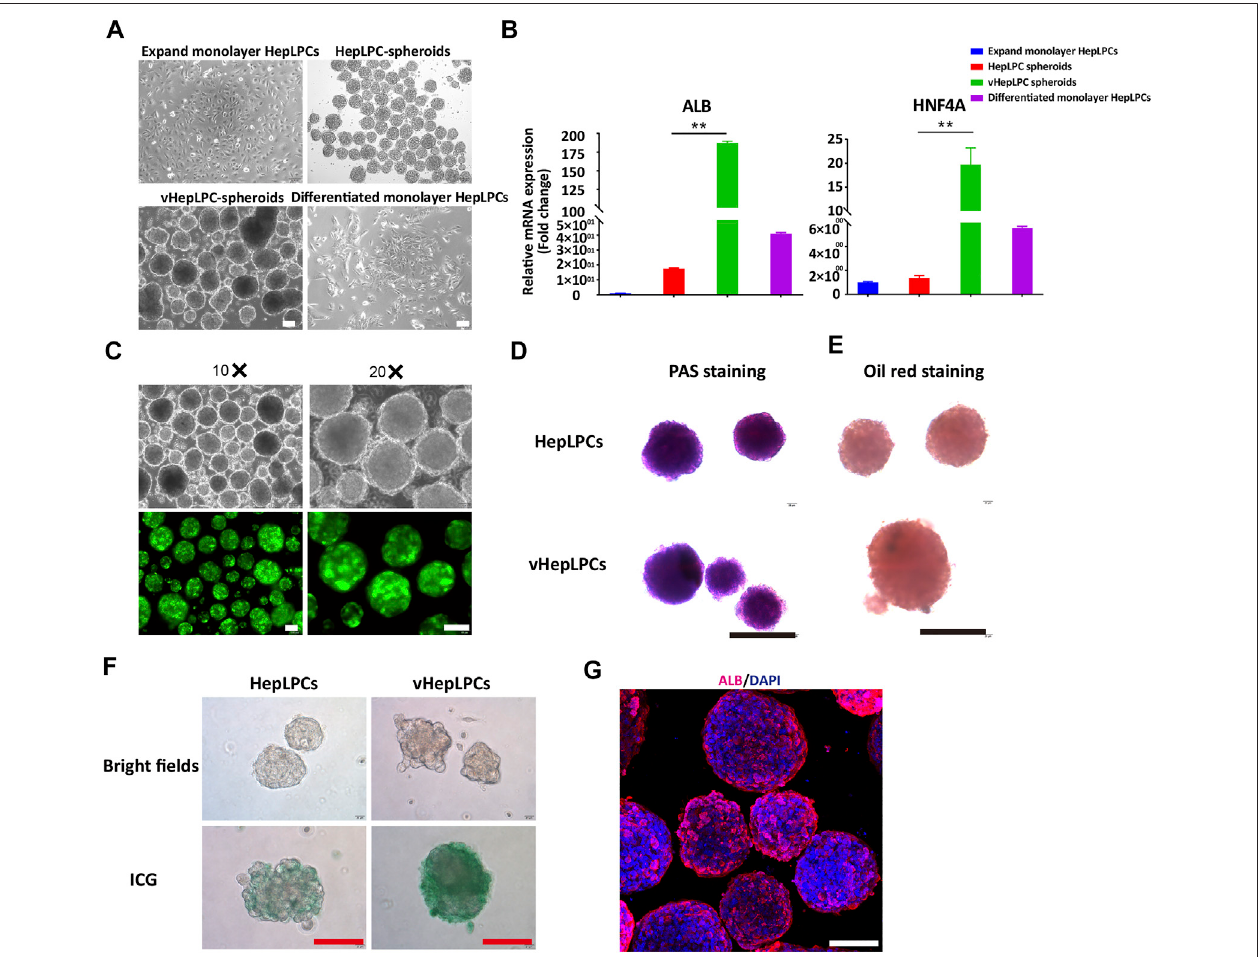
FIGURE 1 | Establishment of a co-culture system using HepLPCs and HUVECs. (A) Representative bright- fi eld images of HepLPCs in expandable monolayer HepLPCs, HepLPCs spheroids, vHepLPC spheroids, and differentiated monolayer HepLPCs. (B) Gene expression was analyzed by qRT-PCR. Hepatic functional markers (ALB, HNF4A) were detected in four groups. Data are normalized to the expandable monolayer HepLPCs group. (C) Fluorescence morphology of HepLPC spheroids on carriers. (D – F) Periodic acid-Schiff (PAS) staining, oil red staining, and ICG stainingofHepLPCs (upperpanel) and vHepLPC spheroids (lower panel). (G) The expression of ALB was determined by immuno fl uorescent staining in vHepLPCs. Nuclei were counterstained with DAPI. Data are shown as mean ± SEM. ** p < 0.01. Scale bars, 100